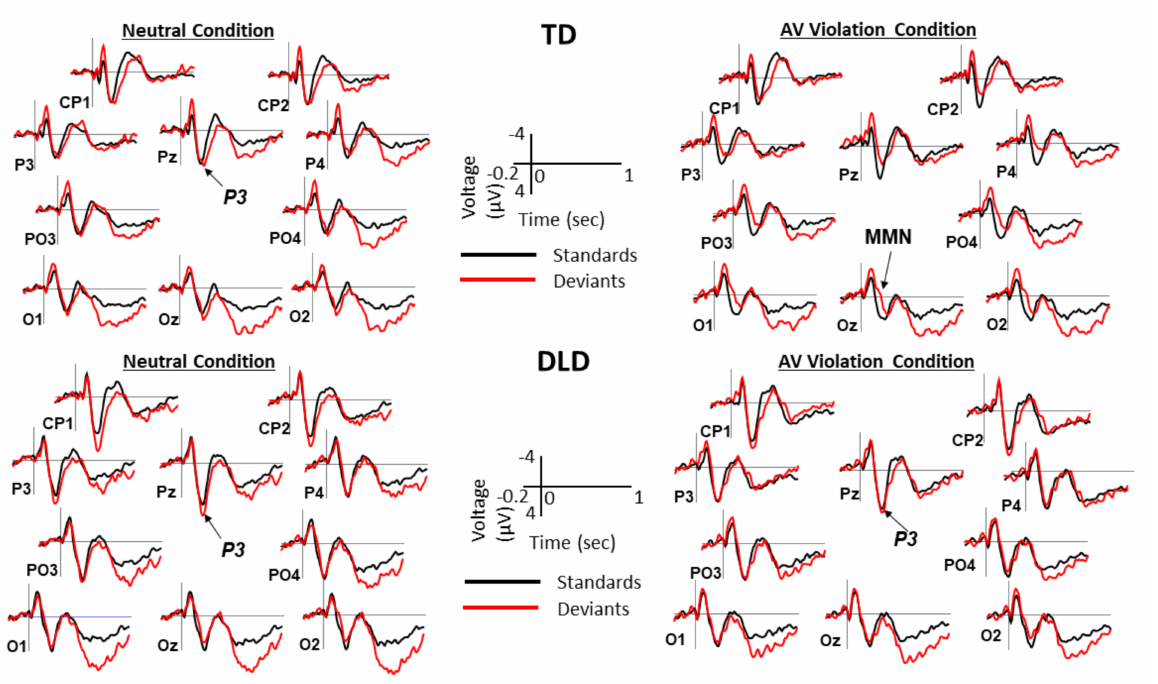
Figure 2. Event-related potential (ERPs) elicited by standards and deviants over the posterior scalp. Grand average ERPs over the 12 posterior sites are shown separately for children with TD and children with DLD. In each condition, grand averages for standards (black lines) are overlapped with grand averages for deviants (red lines). Negative is plotted up. The P3 and MMN components are marked on the Pz and Oz sites, respectively, where present. Time 0 marks the onset of sound. AV =